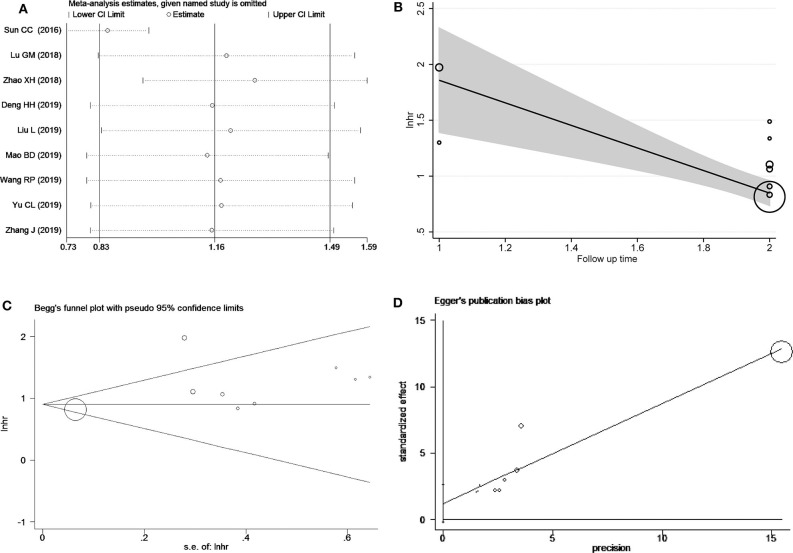
Heterogeneity analysis for the meta-analysis of OS including sensitivity analysis (A), Bgger's test (B), Egger's test (C) and meta-regression (D).